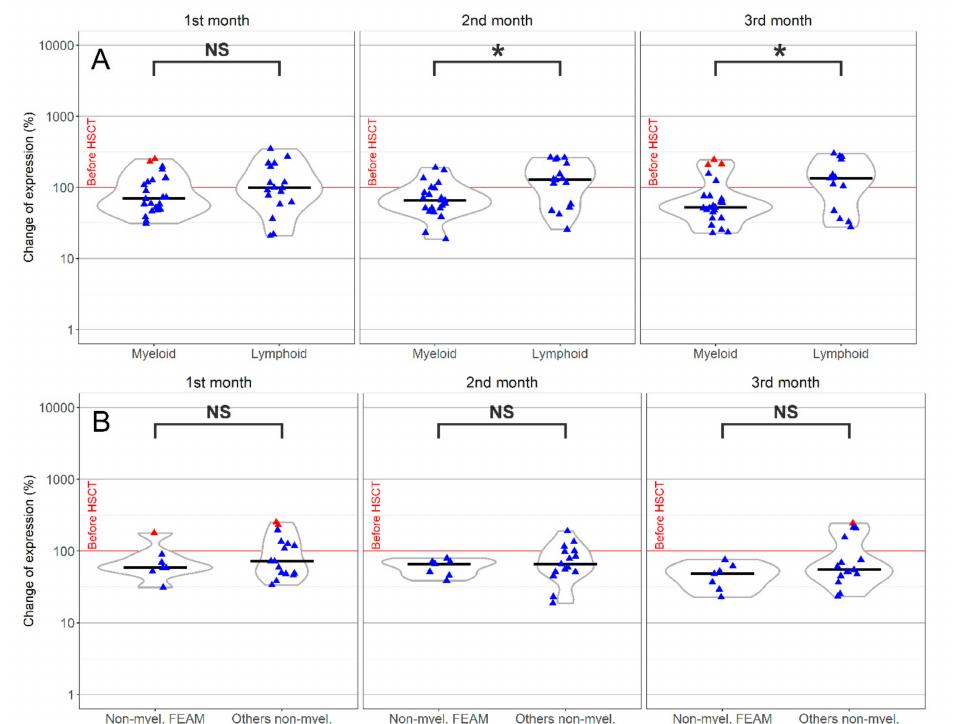
Figure 4. KIR2DL3 di ff erential expression changes in the group of patients with myeloid neoplasia, where the expression decreased compared to the original value, and in a lymphoid group, with a higher expression of NK cells in patients than in the donor before HSCT ( A ). The FEAM (Fludarabine + Etoposid + Ara-C + Melphalan) protocol reduced the expression of KIR2DL3, unlike other conditioning regimens in the myeloid group ( B ). * statistically significant results p < 0.05; NS, without statistical significance ( p > 0.05); outliers, ; Median, .